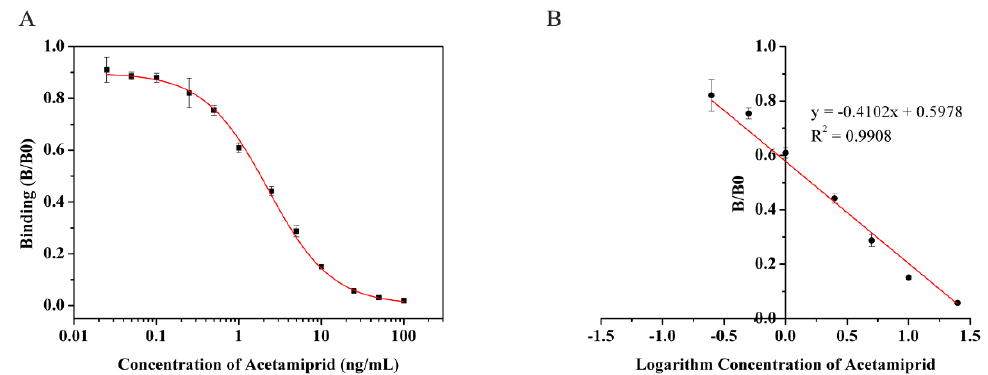
Figure 2. Detection curve of acetamiprid by biotinylated indirect competitive enzyme-linked immunosorbent assay (Bic-ELISA) ( n = 5). a: binding curves of the detection, b: the detection line converted from (a). The SD of ( A ) were 0.0475, 0.0147, 0.0179, 0.0571, 0.0197, 0.0194, 0.0179, 0.0219,